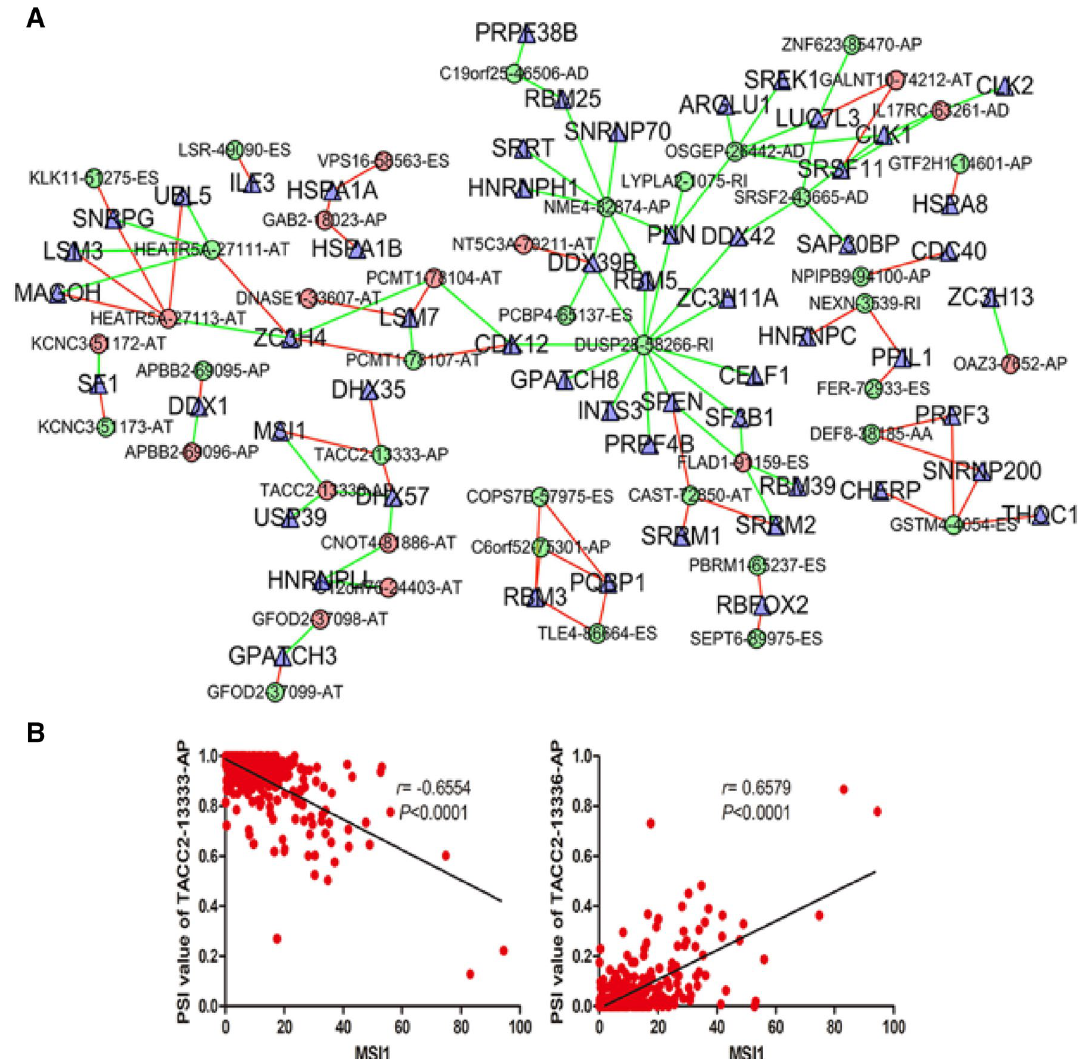
Figure 8. The interaction network and correlation between SFs and AS events. ( A ) The red dots indicate down- regulation, and the green dots indicate up-regulation. The blue triangles indicate SFs. The green lines represent AS events, which were positively correlated with the expressions of SFs, while red lines indicate negative correlations. ( B ) The correlation analysis was performed using Pearson t test. MSI1 could positively regulate -13336-AP ( r = 0.6579, P < 0.0001) and negatively regulate TACC2TACC2-13333-AP ( r = − 0.6554, P <